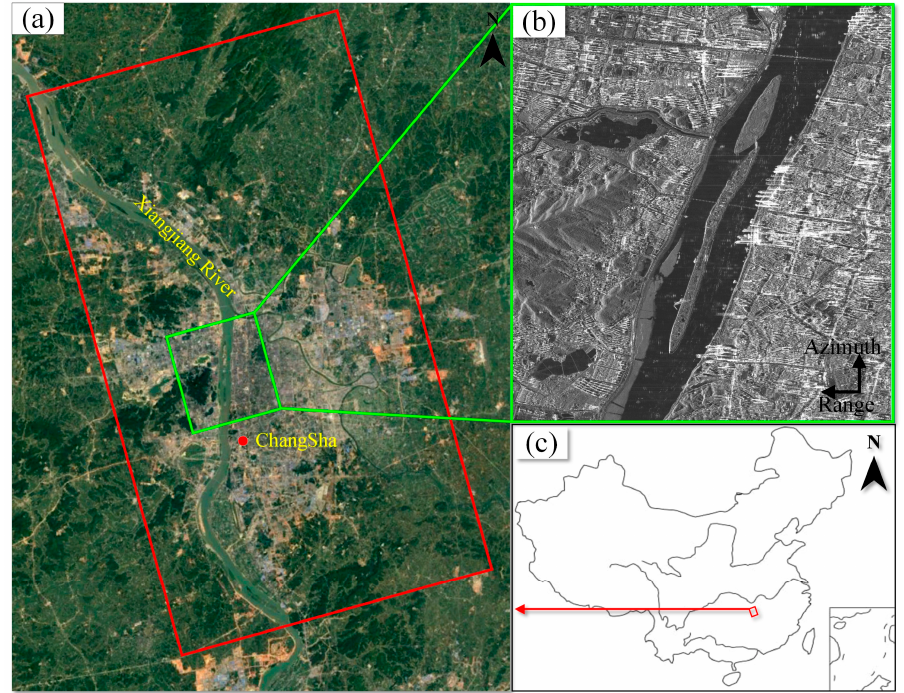
Figure 2. Study area features at different scales: ( a ) the location of the study area, ( b ) an amplified image of the study area, and ( c ) the scale of the region in China.